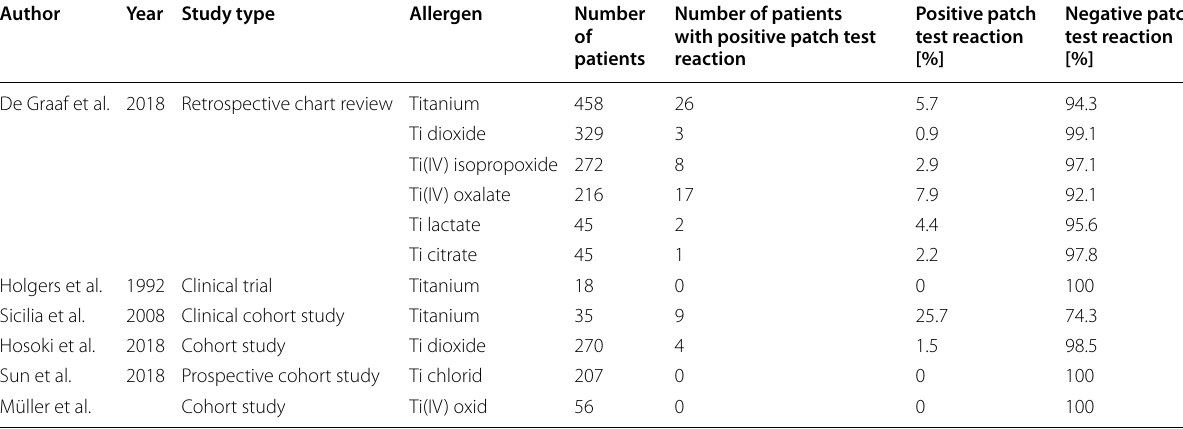
Table 1 List of included studies related to titanium allergy